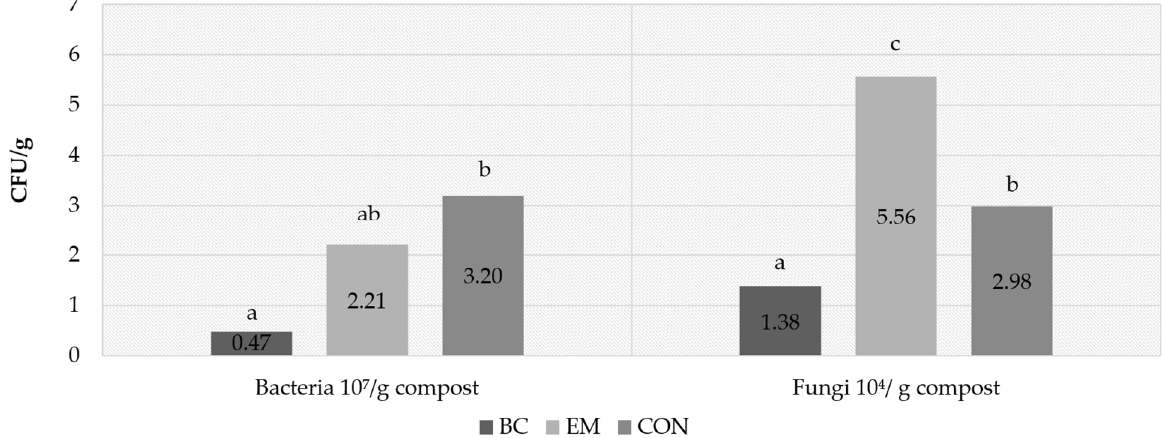
Figure 6. Mass of bacteria and fungi in composts. Same letter on the bar indicates no statistical differences between composts (Duncan test, p < 0.05).